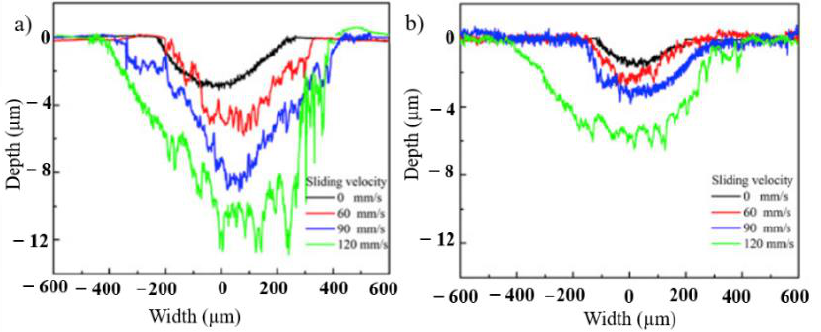
Figure 11. 2D wear profiles of the ( a ) base and ( b ) USRP Inconel 690 alloy tubes from impact sliding wear test. Reprinted with permission from ref. [64]. Copyright 2020 Else- vier.